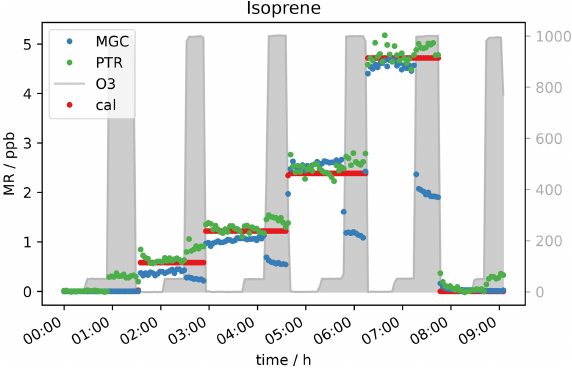
Figure 8. Different isoprene levels at 0, 50 and 1000ppb O 3